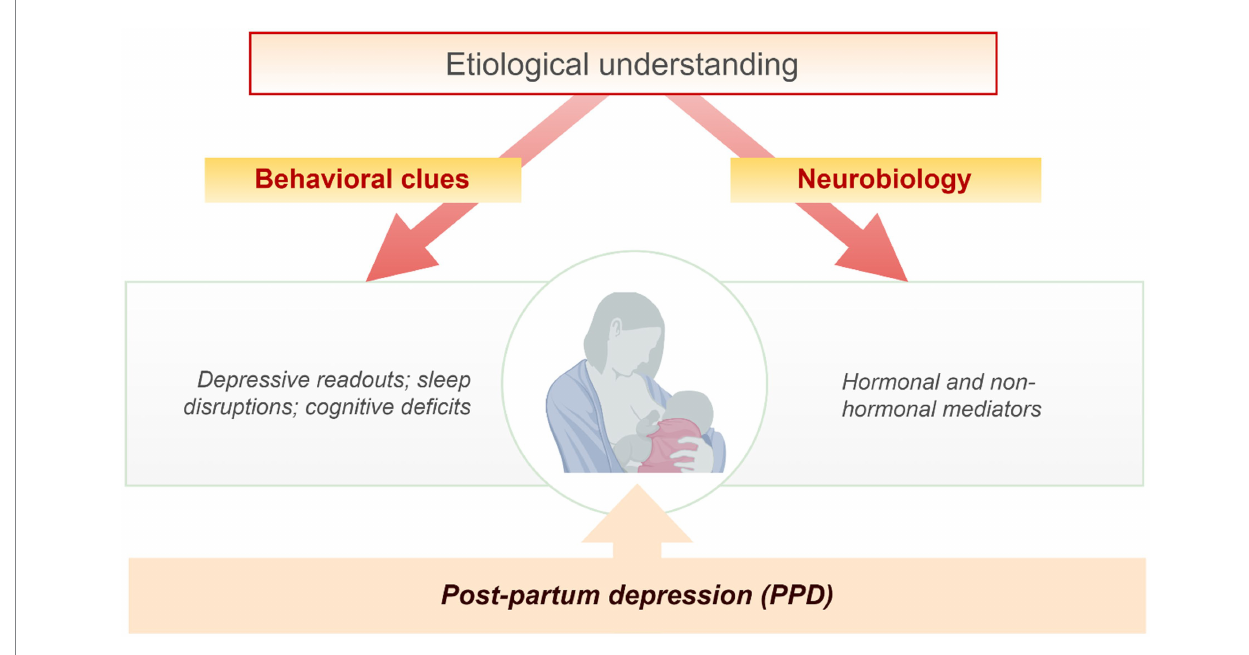
FIGURE 1 Etiological understanding of post-partum depression (PPD). The behavioral clues and neurobiological aspects suggestive of depressive signs, sleep, and cognitive disruptions, hormonal and non-hormonal alterations are important components of PPD